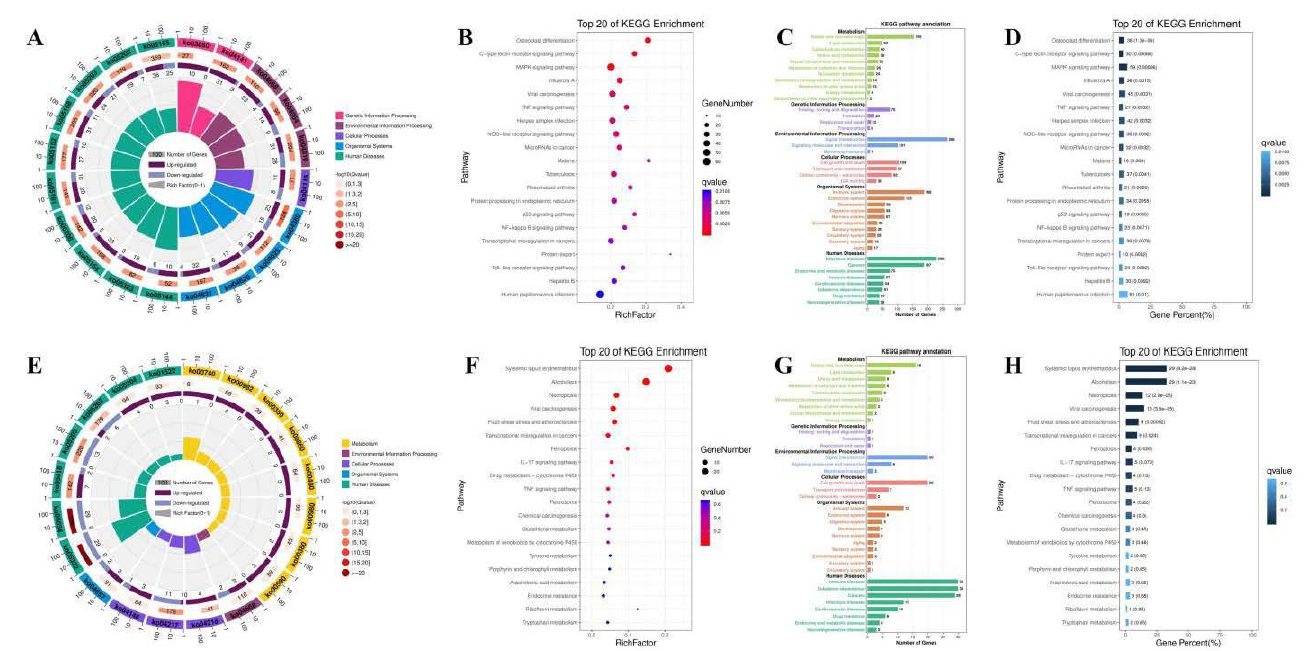
Figure 10. Gene Ontology term analysis of differentially expressed mRNA. C group and CV group: Gene Ontology anno- tation of mRNA in cellular components ( A ), molecular functions ( B ), and biological process ( C ). CV group and CVM group: Gene Ontology annotation of mRNA in cellular components ( D ), molecular functions ( E ), and biological process ( F ). GO, Gene Ontology; CC, cellular component; MF, molecular function; BP, biological process.